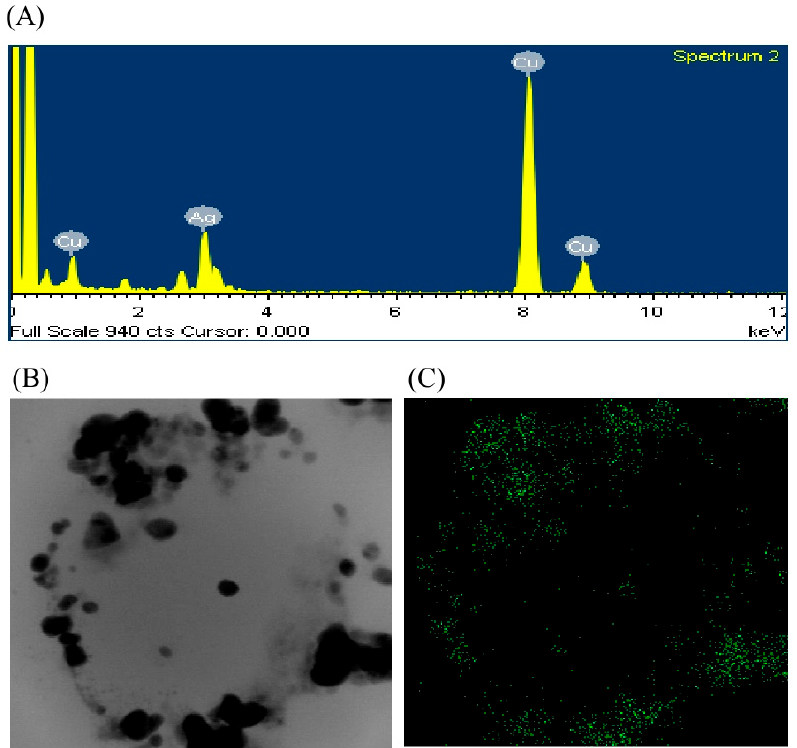
Figure 3. Energy dispersive X-ray (EDX) spectrum of synthesized AgNPs ( A ), Field emission–transmission electron microscopy (FE–TEM) image used for elemental mapping ( B ) and distribution of silver in elemental mapping ( C ).